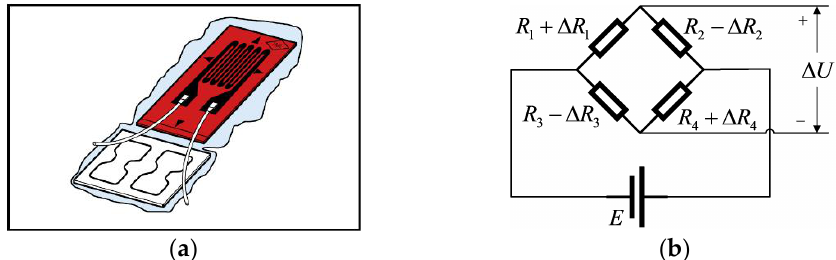
Figure 3. Structure and application of a strain gauge. ( a ) Strain gauge structure diagram. ( b ) Full bridge measuring circuit.